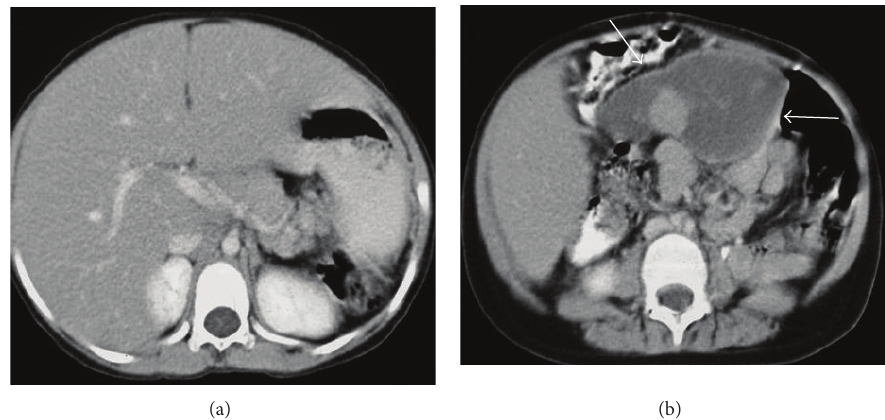
Figure 8: Axial contrast enhanced CT images of a 19-year-old female patient who was presented with acute abdominal pain. There is no splenic tissue at left upper quadrant (a) and a heterogenously hypodense mass (arrows) of a torsioned wandering spleen at midline (b) which was proven surgically. Hypodense parenchyma indicates infarction.